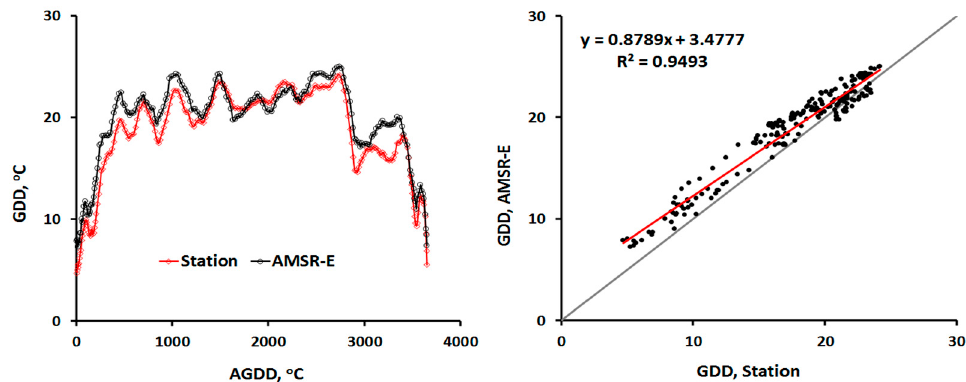
Figure 4. ( left ) Time series plot of AMSR-E (black) and station (red) daily GDD as a function of station AGDD for 2003 at Kirovohrad, Ukraine (site 15); and ( right ) linear regression fit of AMSR-E GDD with station GDD for the same dataset yielding strong correspondence with r 2 = 0.95. Note also the bias (intercept) and the underestimation (slope < 1) of the AMSR-E GDD relative to the station GDD.